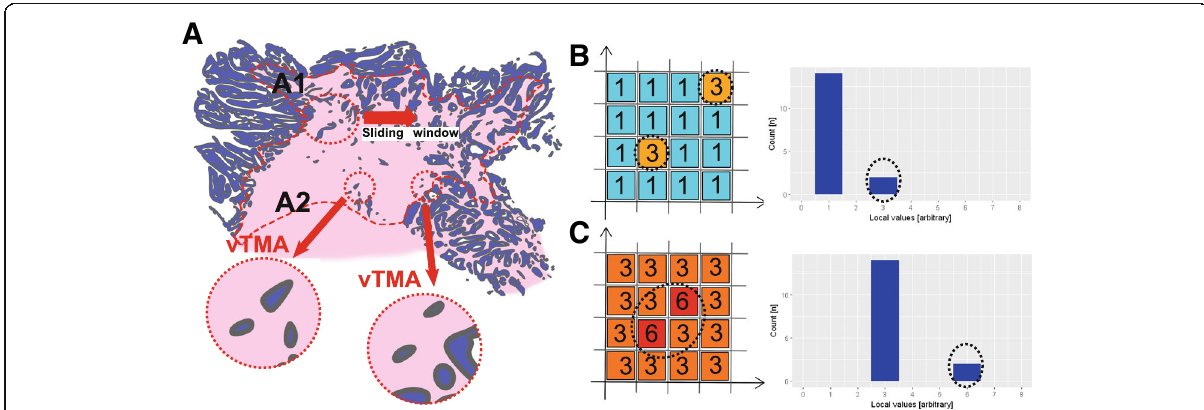
Fig. 3 Sketch of the analysis. A) ROI tumor (not shown) and the ROI border (dashed red line) were manually delineated by a pathologist (CW). A1: a sliding window moved over the ROI border and cropped every half TMA diameter in the underlying, TMA core-sized image. A2: The resulting tile (exactly the size of one TMA core) was then defined as a virtual TMA (vTMA). b , c This procedure leads to a value (number of tumor buds or budding score) per vTMA. This spatial data could be plotted as a heat map (example heat maps with arbitrary values in the left part) or as a histogram (right part of the